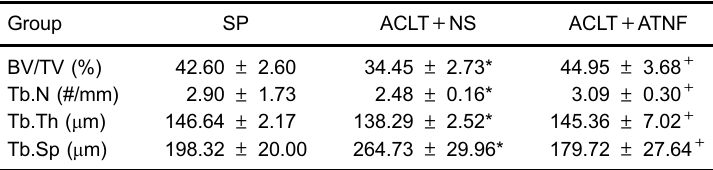
Table 2. Bone histomorphometric analysis of subchondral trabecular